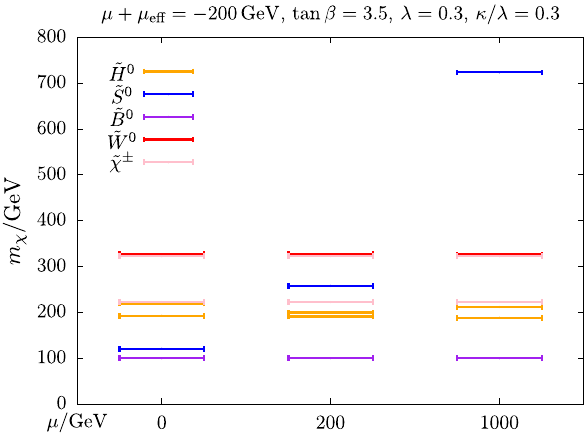
Fig. 1 The masses of the neutralinos and charginos are shown for different values of μ . The effective higgsino mass parameter is fixed at μ + μ eff = − 200GeV, and the mass parameters for the gauginos are set to M 1 = 100GeV and M 2 = 300GeV. The other relevant parame- ters are given in the legend of the figure. The mostly bino- and wino-like states ˜ B 0 (purple) and ˜ W 0 (red) as well as the charginos ˜ χ ± (rose) have (nearly) constant masses. The masses of the two mostly higgsino-like states ˜ H 0 (orange) and the mostly singlino-like state ˜ S 0 (blue) vary